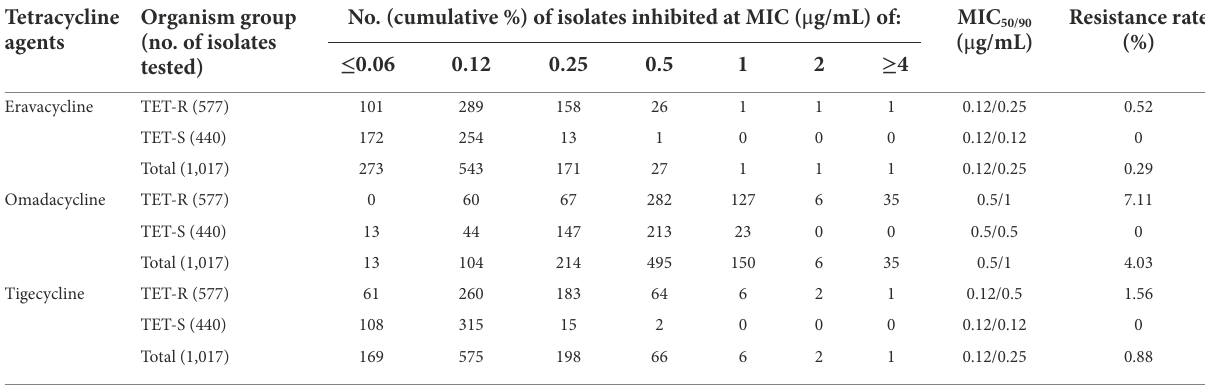
TABLE 1 Antimicrobial activity of eravacycline, omadacycline and tigecycline against Staphylococcus aureus isolates. Tetracycline agents